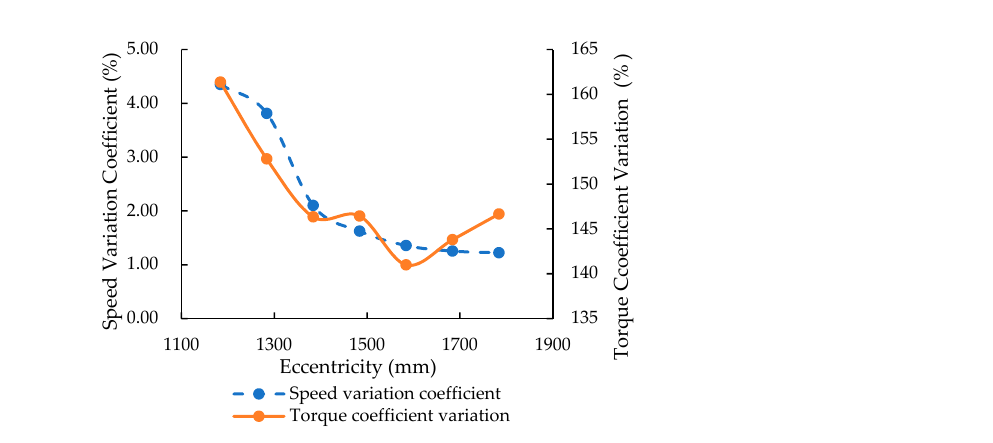
Figure 15. Relationship between speed variation coefficient, torque variation coefficient and eccentricity.